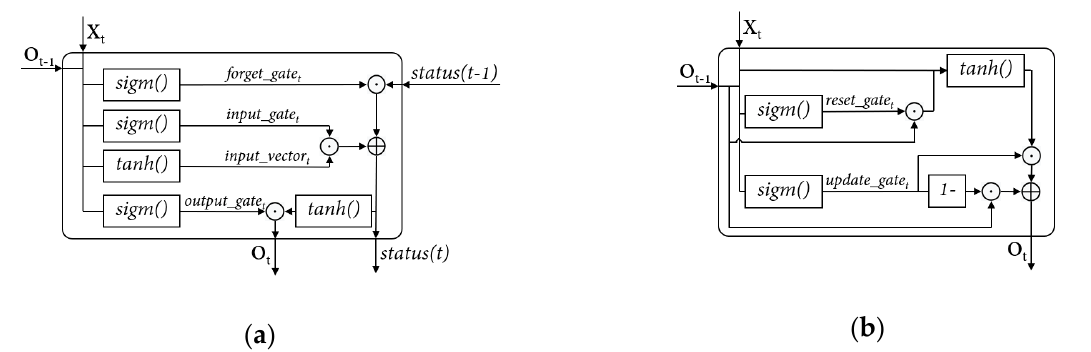
Figure 1. The architecture of special units in RNN: ( a ) a LSTM unit; ( b ) a GRU.